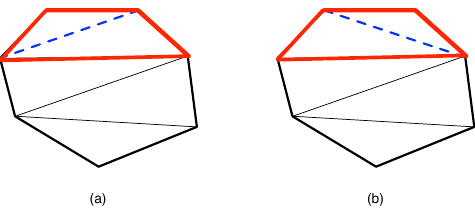
Figure 6. ( a ) A triangulation, with one diagonal of a quadrilateral highlighted; ( b ) an adjacent triangulation, resulting from the reconfiguration step of flipping the